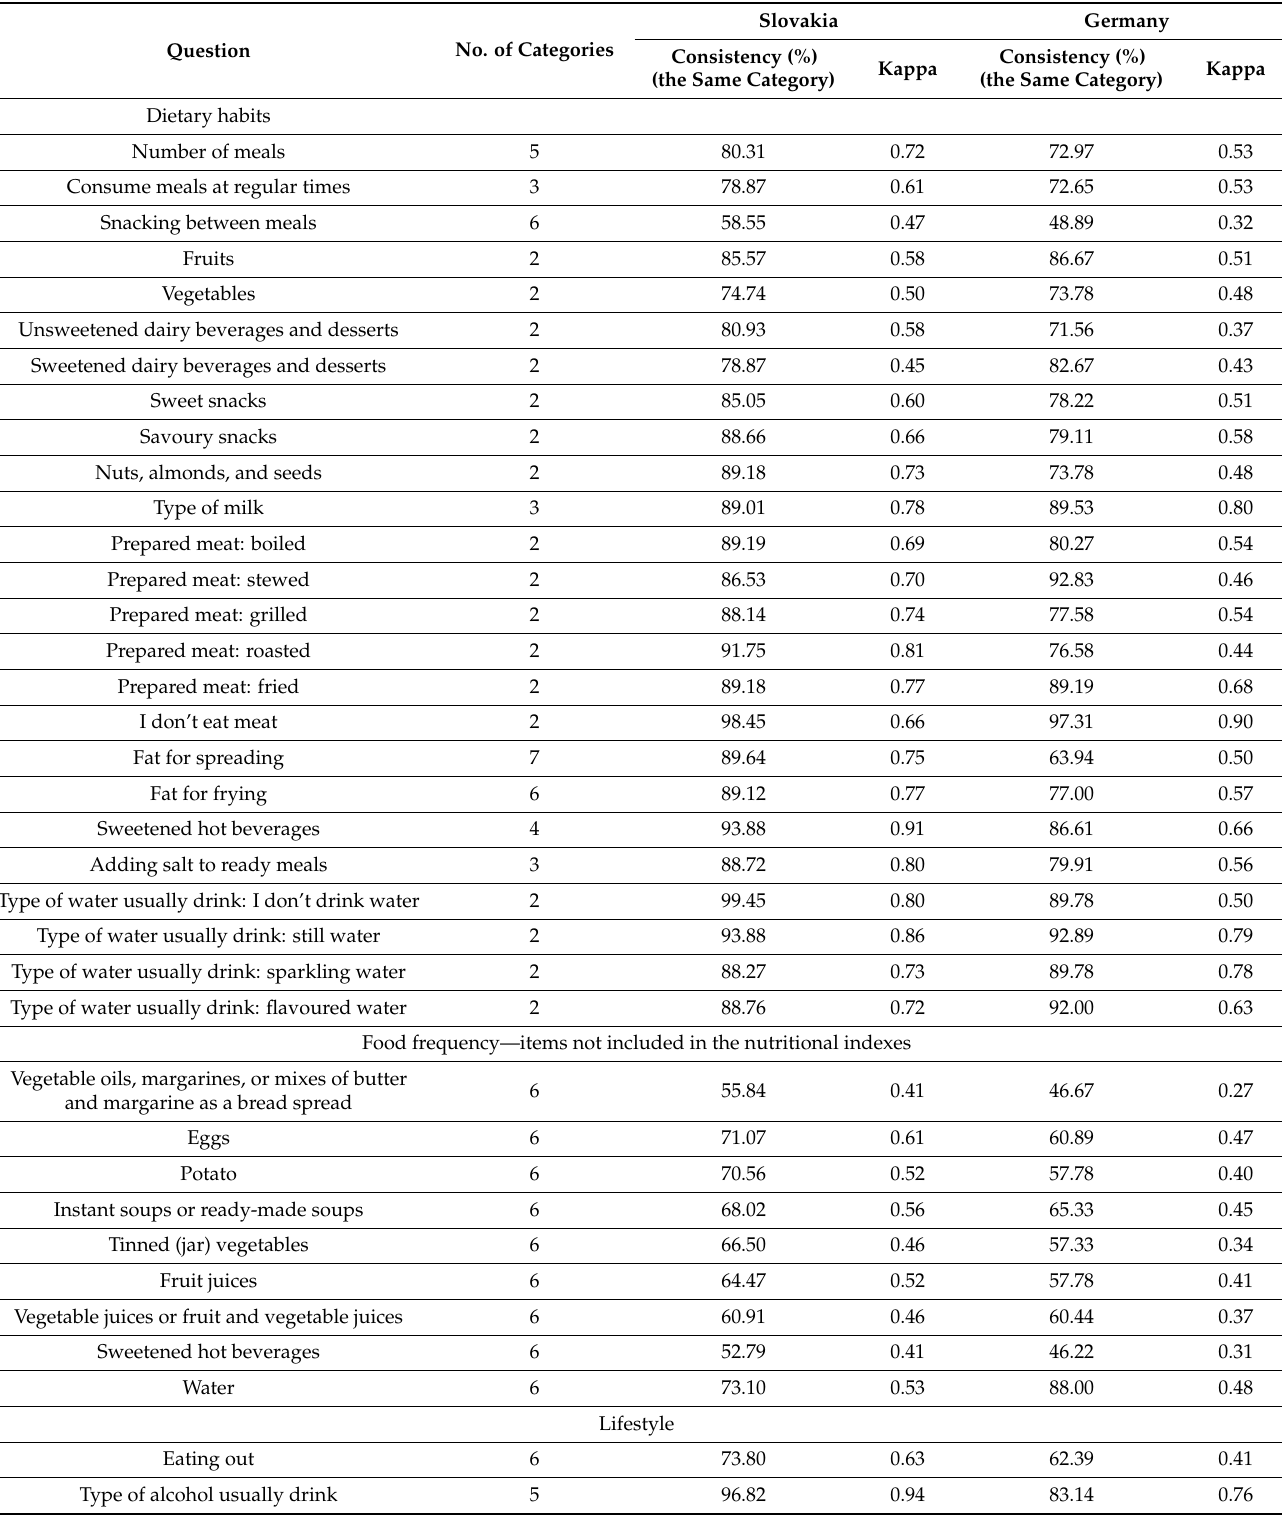
Table 4. Consistency coefficients for the test and retest in both groups of